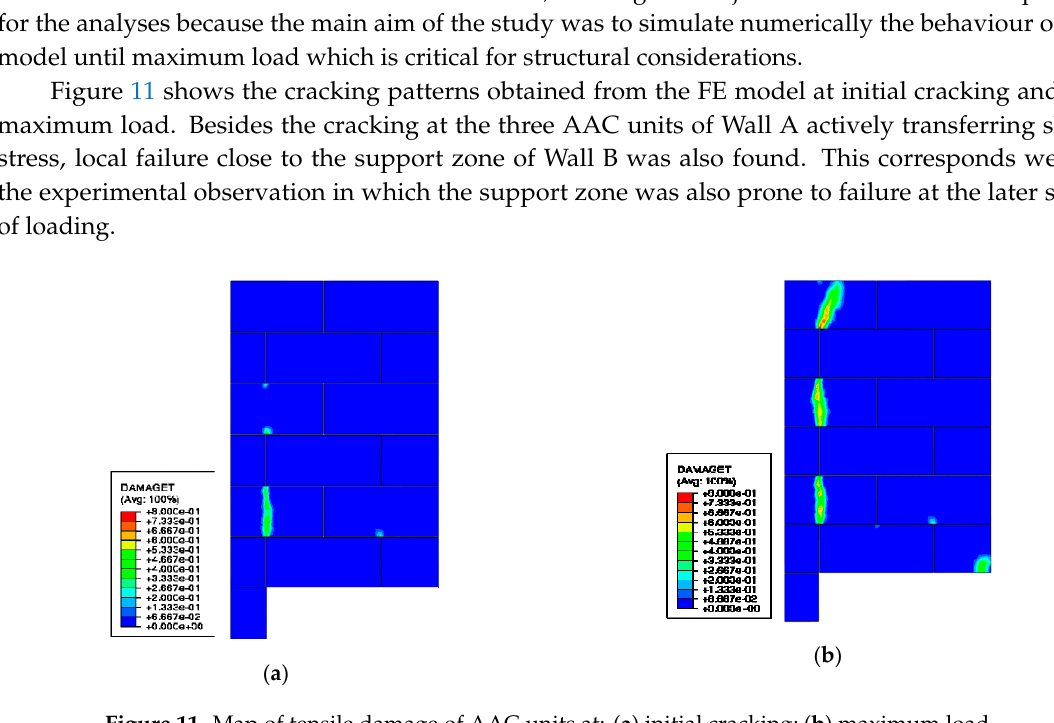
Figure 11. Map of tensile damage of AAC units at: ( a ) initial cracking; ( b ) maximum load.